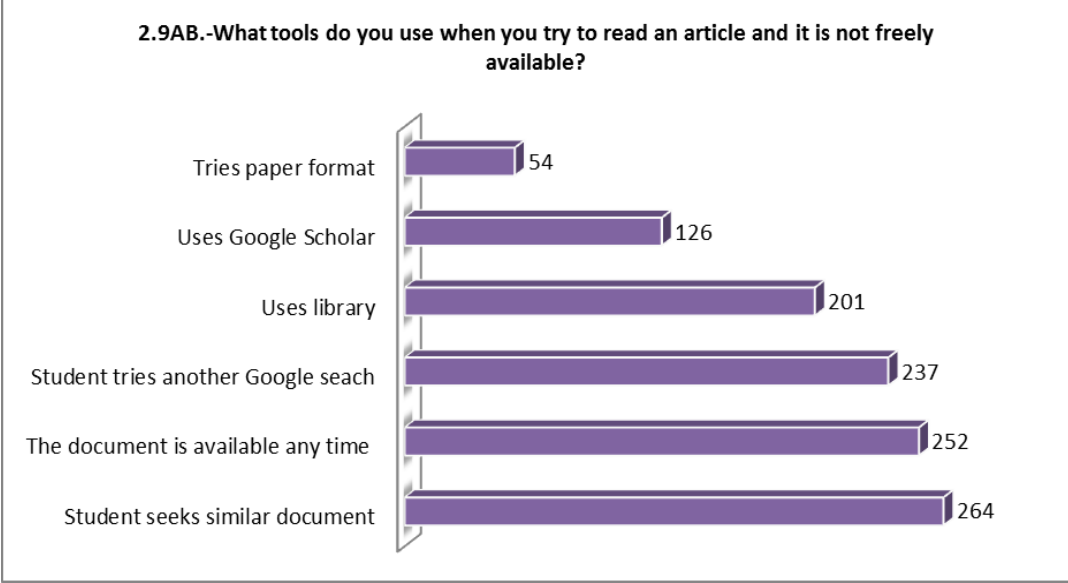
Figure 3 . Open Question 2.9AB.